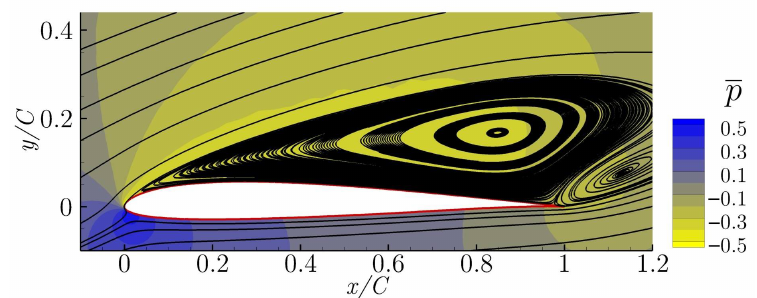
Figure 3. Averaged streamlines and pressure field of baseline case ( C l =